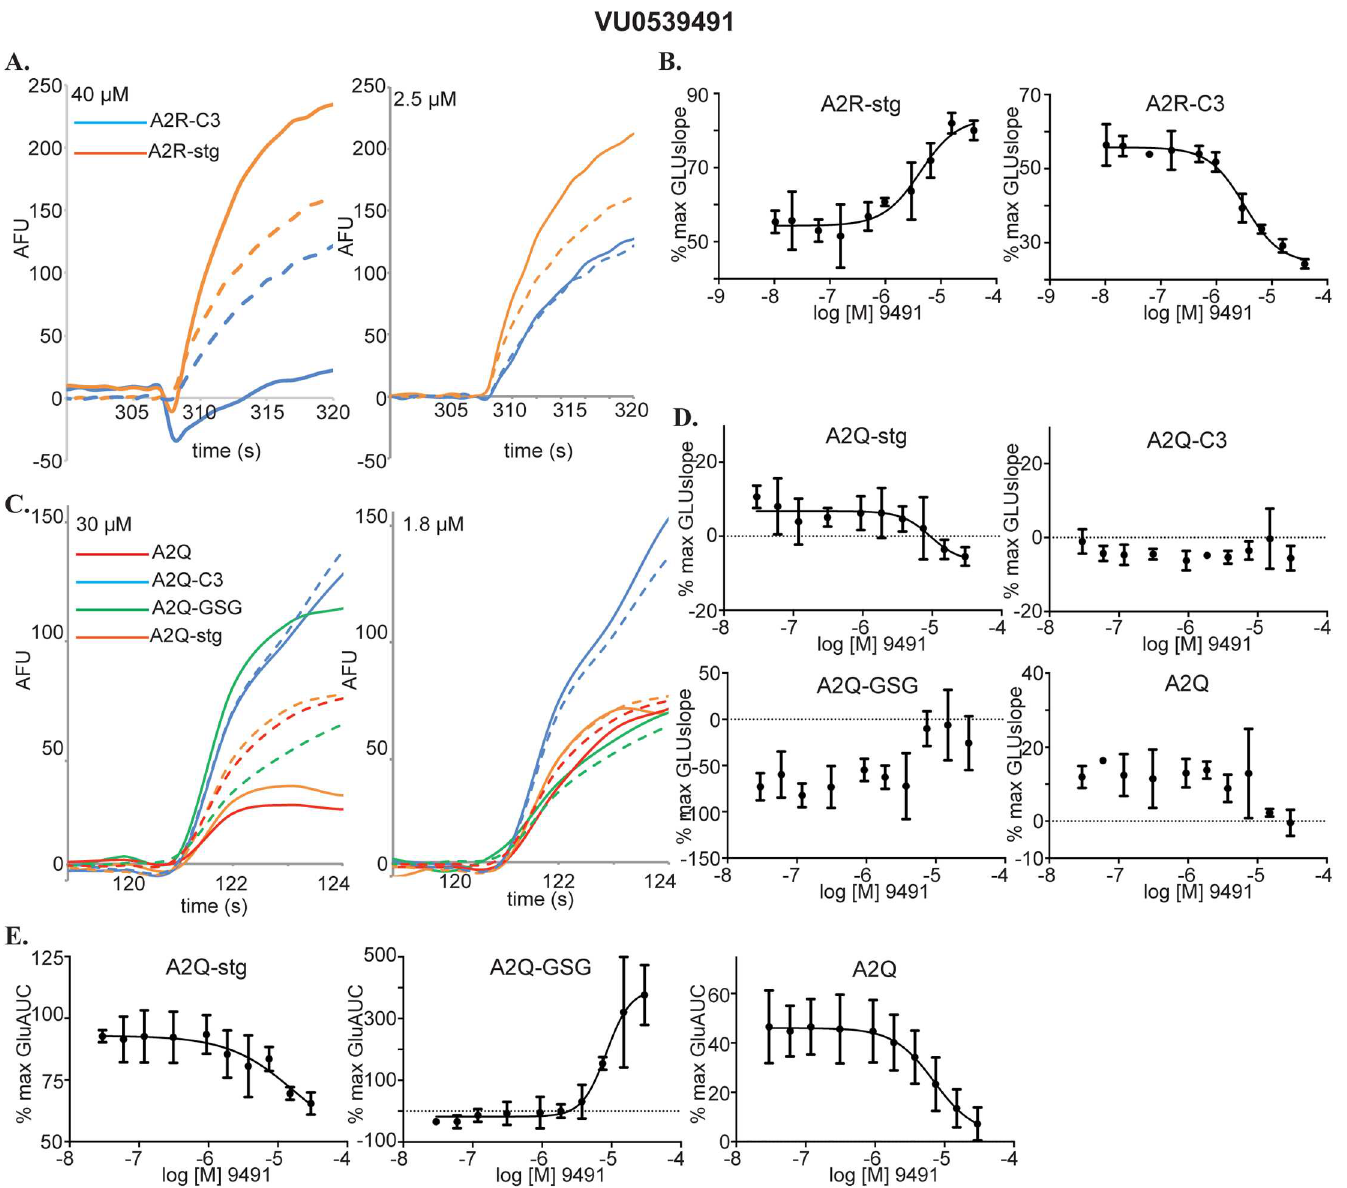
Fig 9. Characterization of VU0539491. (A) Raw data for compoundCRCs in the VSD assay. A2R-stg (orange)and A2R-C3 (blue). EC 50 GLU traces are representedby dashed lines. Compoundconcentrations are indicatedin the top left corner. (B) CRCs calculatedfrom GLUslopein VSD assay for A2R-stg and A2R-C3. (C) Raw data for compoundCRCs in the calcium flux assay. A2Q (red), A2Q-stg (orange), A2Q-GSG (green), and A2Q-C3 (blue). Traces obtainedfrom applying1 mM glutamateare representedby dashed lines. (D) CompoundCRCs calculatedfrom the GLUslope1 windowin our calcium flux assay for A2Q-stg, A2Q-C3, A2Q-GSG, and A2Q cell lines. These show negativeand positive trends but no curve fits. (E) Compound CRCs calculated from the AUC in the GLUmaxmin windowof the calcium flux assay plotted as %max AUC vs. log [compound]as in